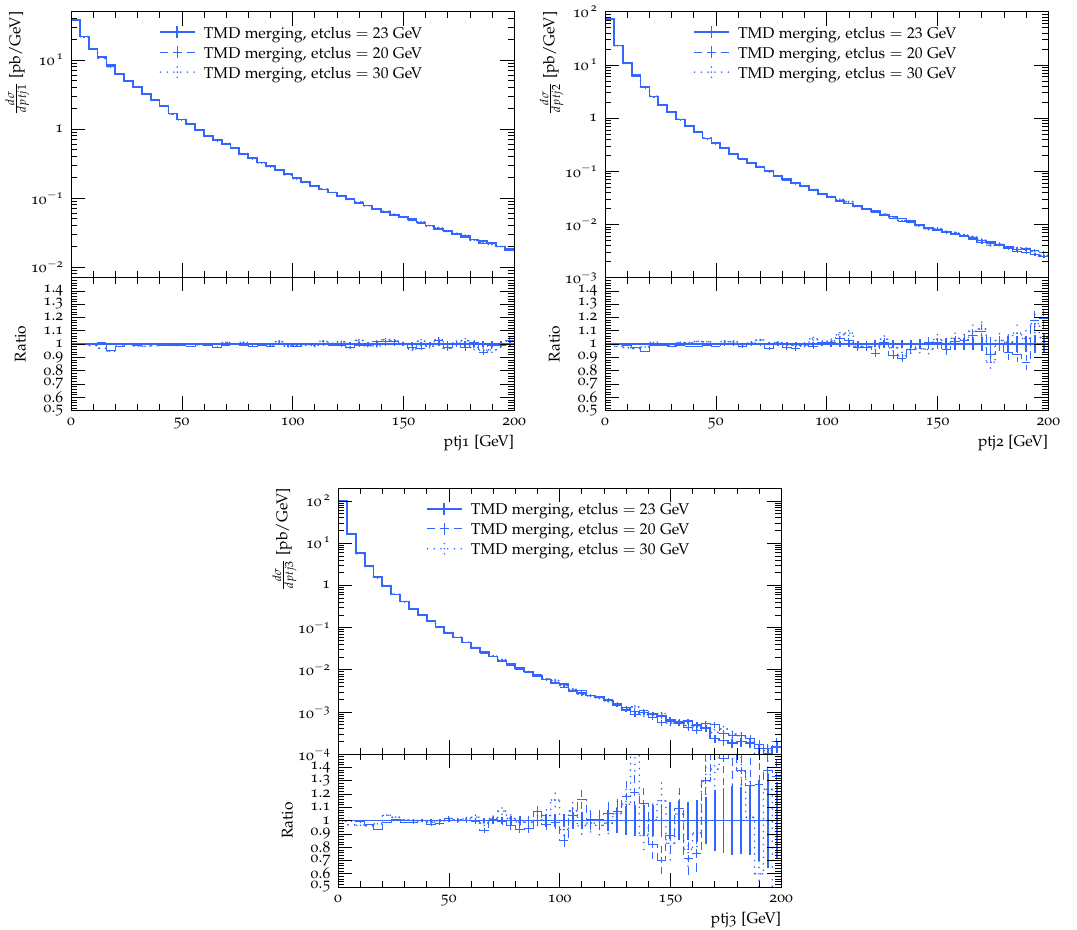
√ s = 8 TeV. The transverse